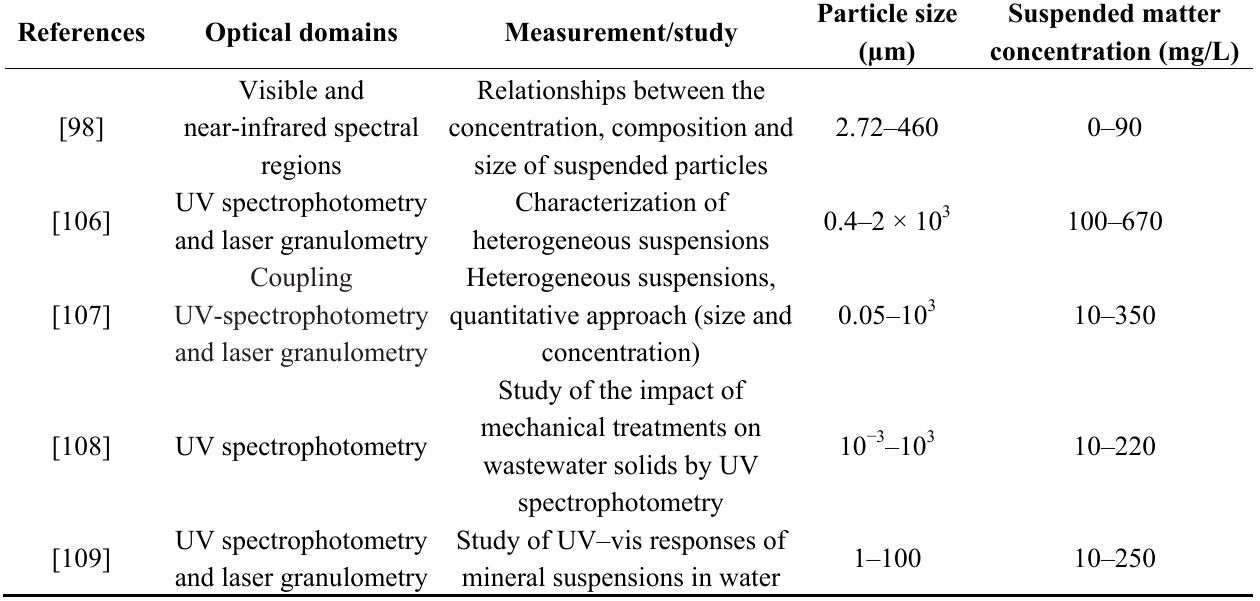
Table 2. Characterization of particles by UV (water and